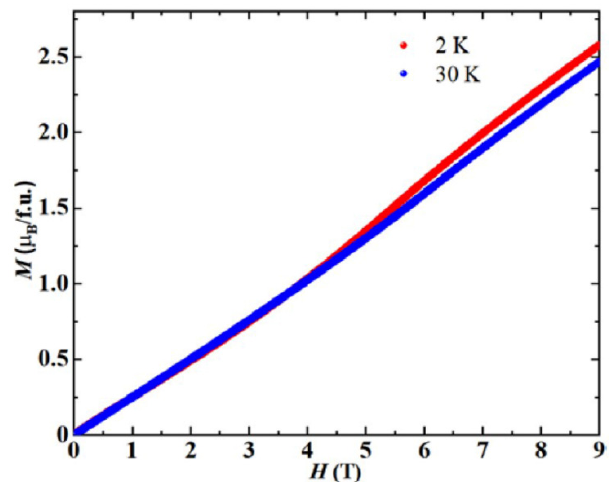
Figure 5. Isothermal magnetization ( M ) as a function of applied field ( H ) at 2 K and 30 K.